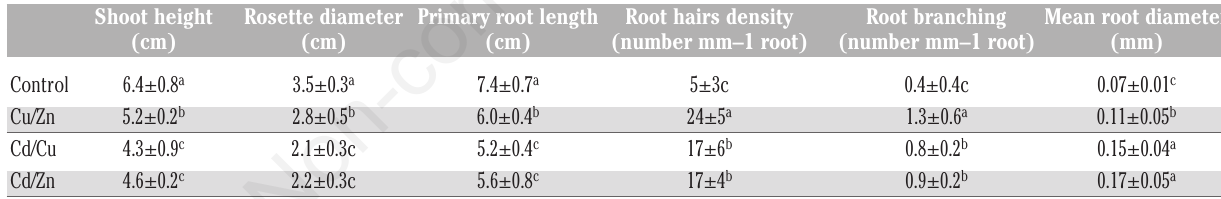
and 5 µM CuSO (Cd/Cu), and 10 µM CdSO 4 4